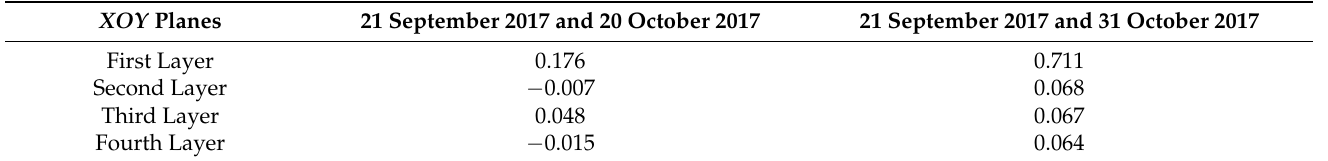
Figure 9. Temperature field cloud map of the fourth layer on the XOY plane on 11 October 2017. The area with lower temperature in the middle is near the ventilated air duct. Table 8. The influence of aeration operation on the temperature correlation on the XOY plane.